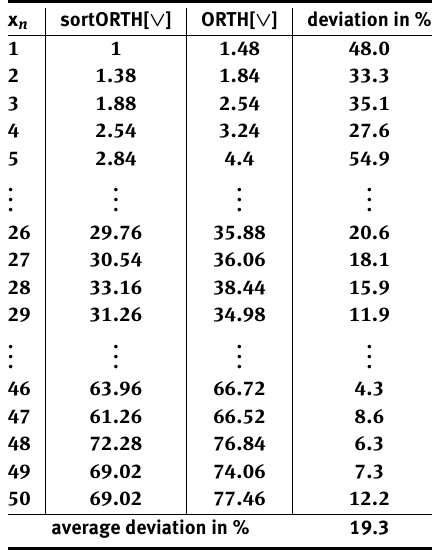
Table 2. Average number of conjunctions in the orthogonal